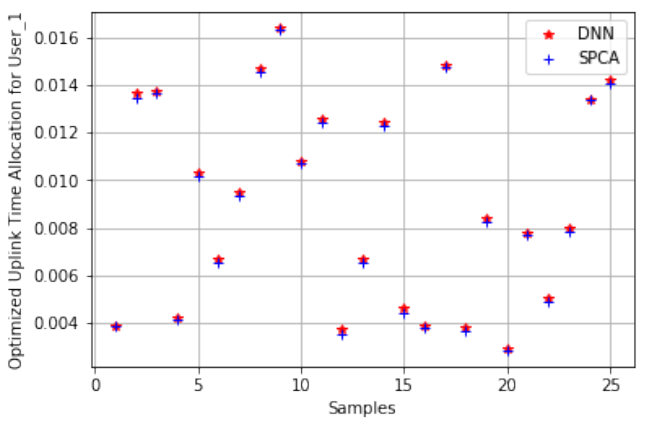
Figure 8. Optimal uplink time allocation samples from the DNN and SPCA for User 1.